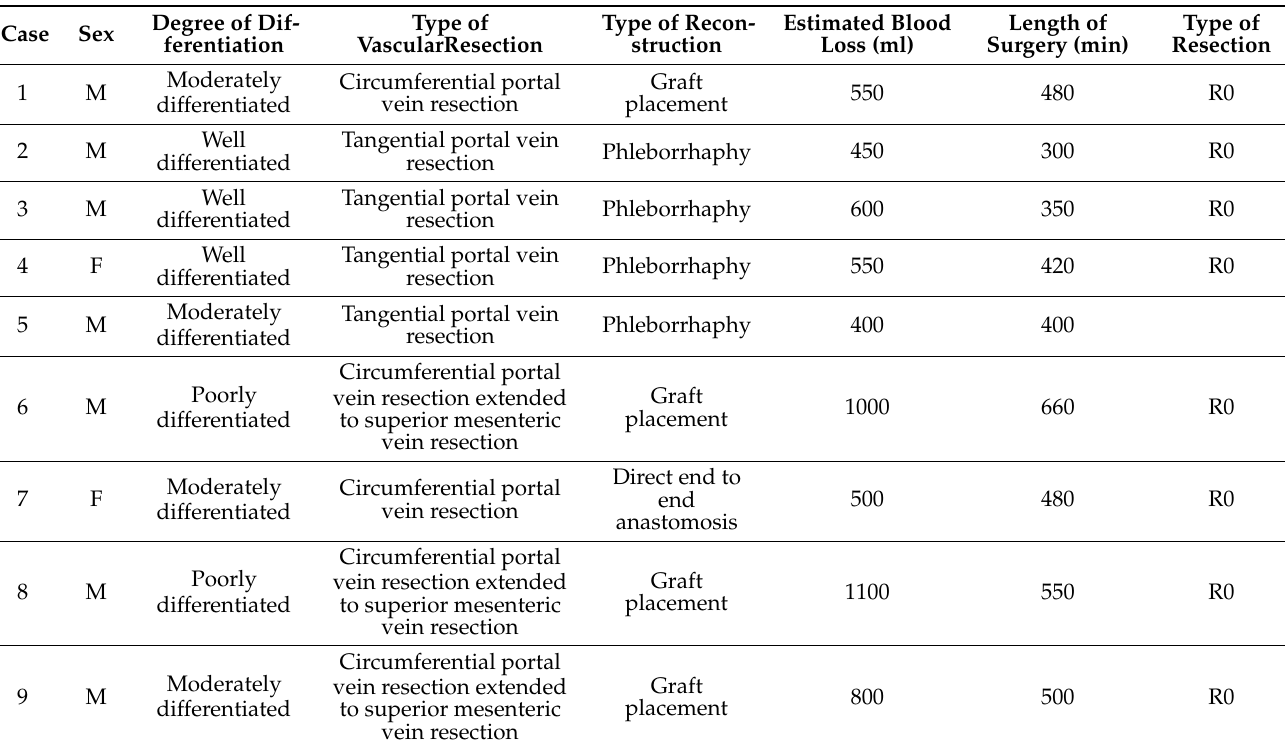
Table 1. Intraoperative details of patients submitted to pancreatic head resection en bloc with portal vein